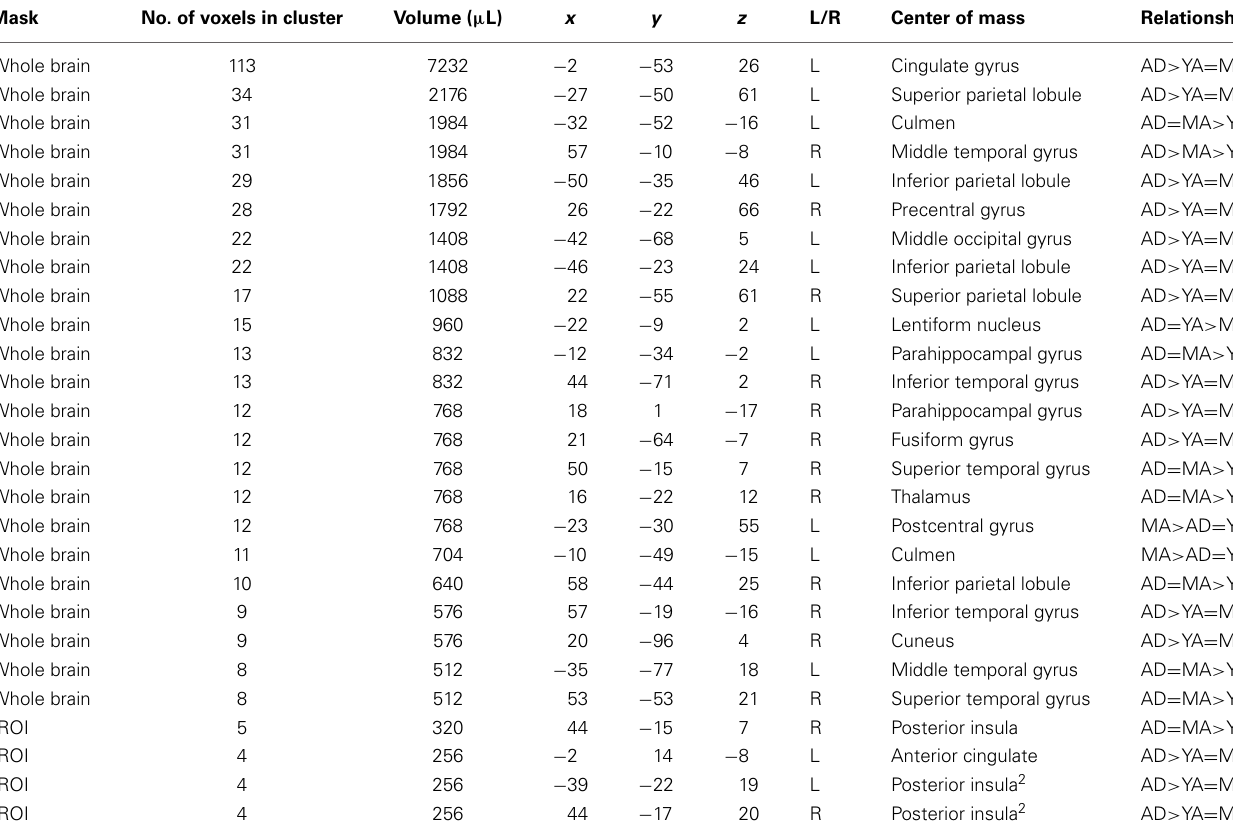
Table 3 | fMRI results for main effect of